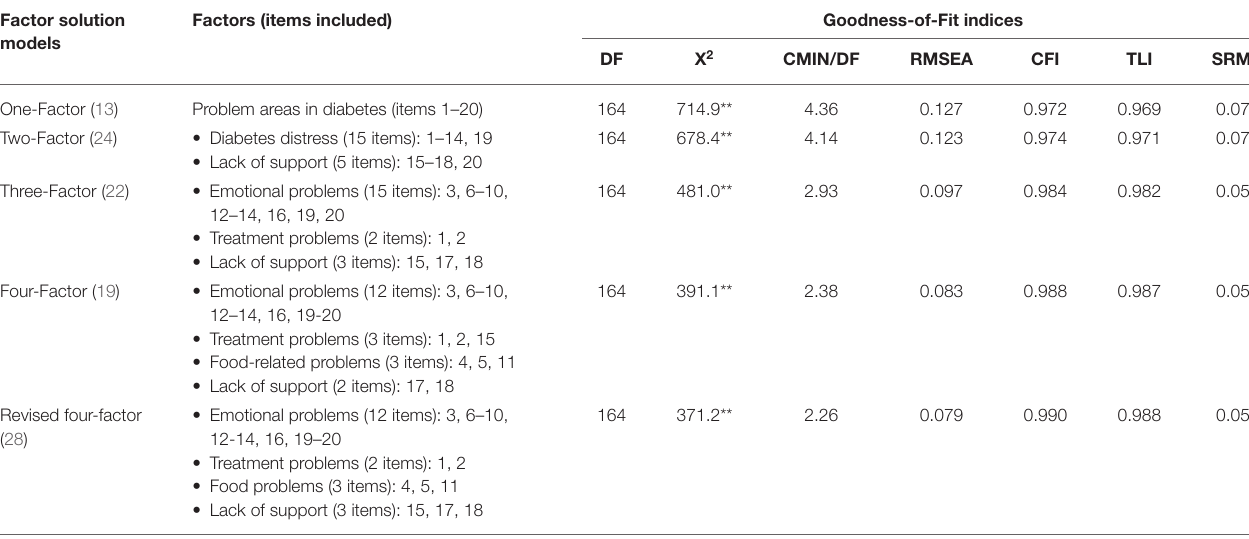
TABLE 2 | Comparisons of fit indices of different AR-PAID factor solutions ( N = 200). Factor solution